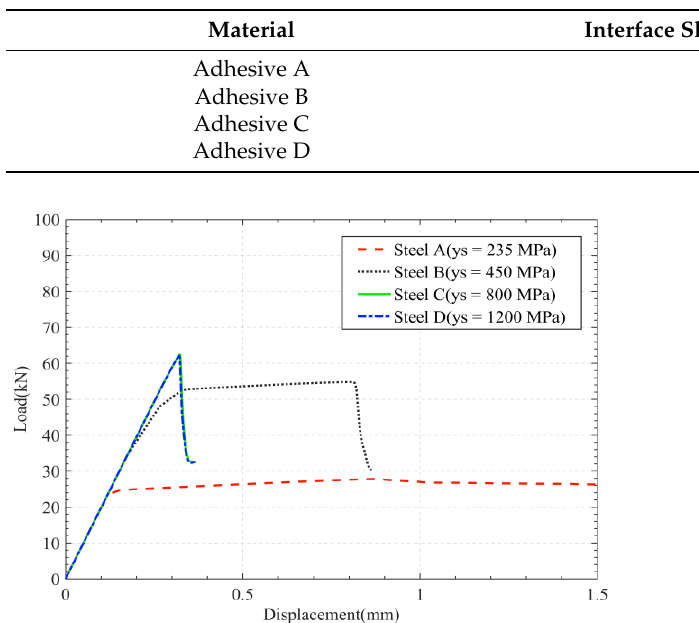
Table 3. Shear strength of different adhesives.